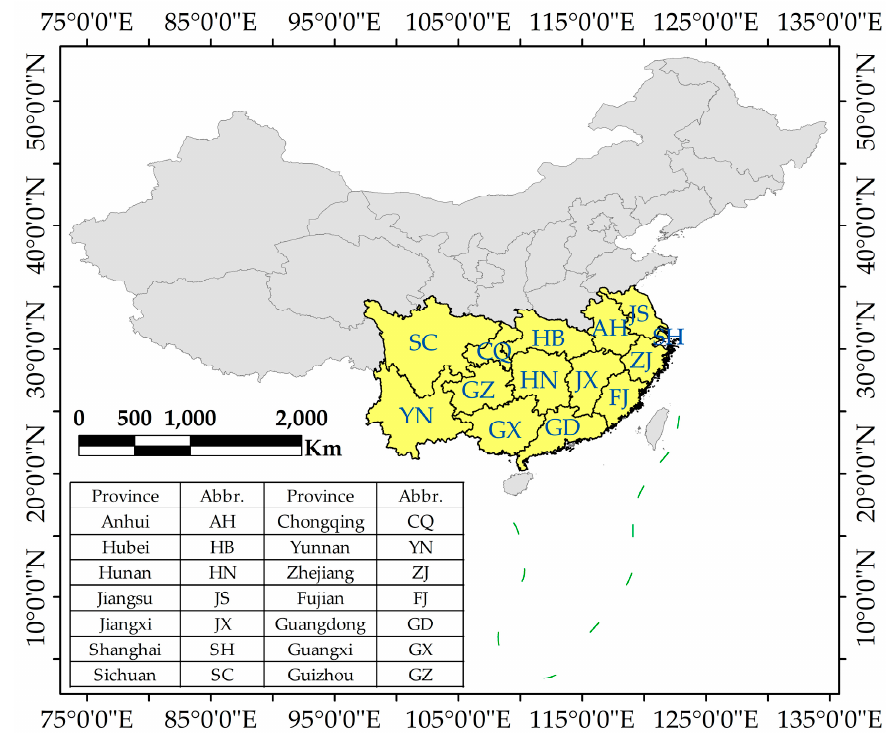
Figure 1. Study area. Fourteen provinces of southern China were selected as study cases considering the spatial and temporal coverage of monthly VIIRS DNB